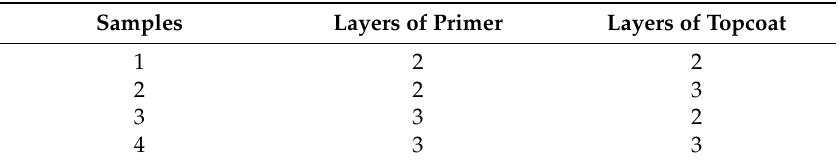
Table 1. Number of primer and topcoat